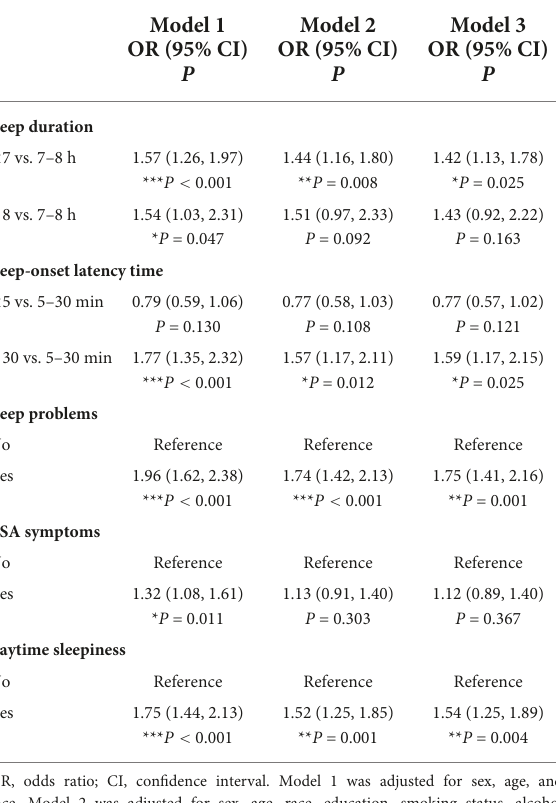
TABLE 2 Adjusted odds ratios for associations between sleep-related disorders and total CVD.